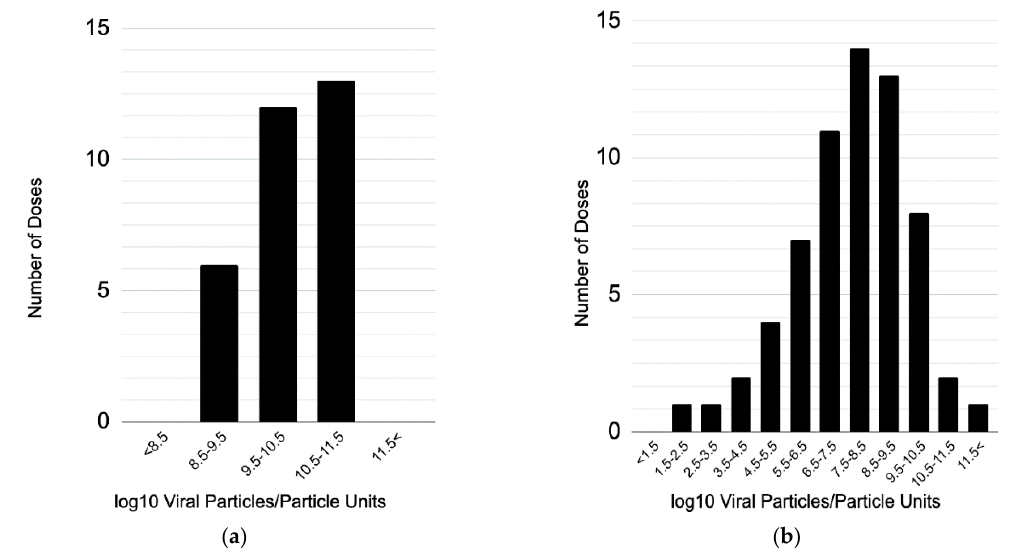
Figure 1. Frequency of dose magnitudes for all adenoviral vector vaccine dose-response studies with doses measured in VP/PFU in ( a ) humans and ( b ) mice.